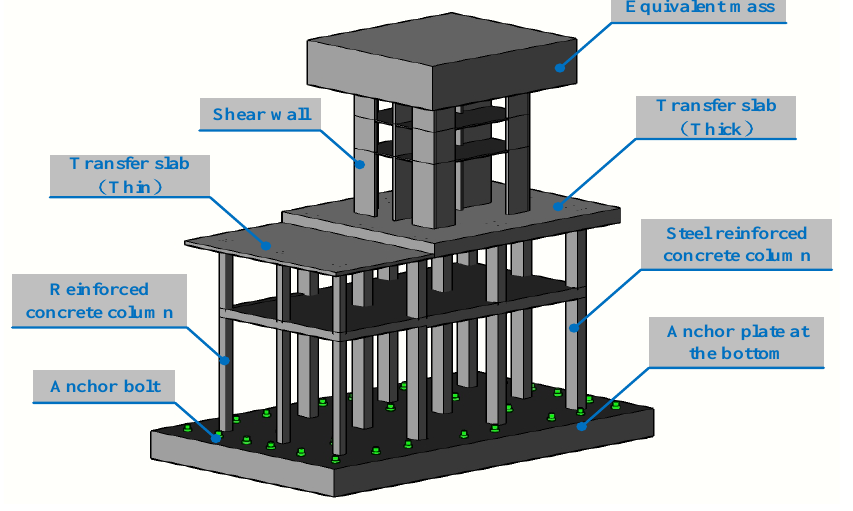
Figure 3. Experimental object.